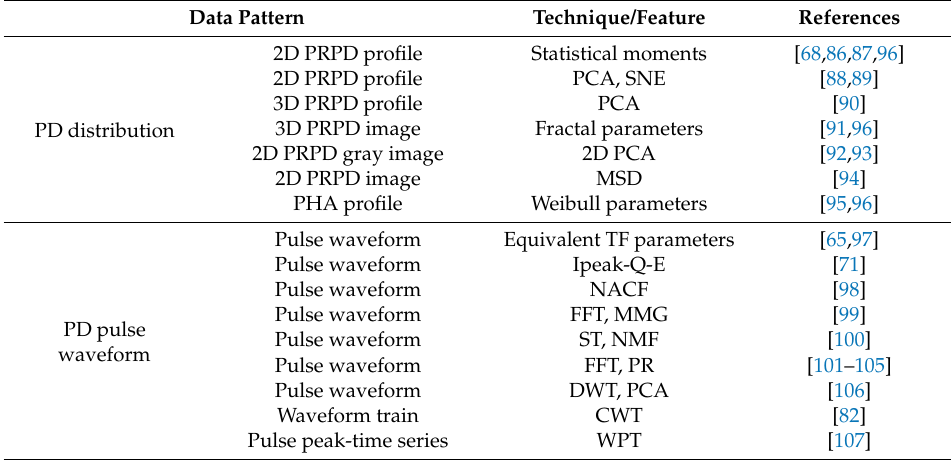
Table 6. Characteristics of PDs online measurement system for large